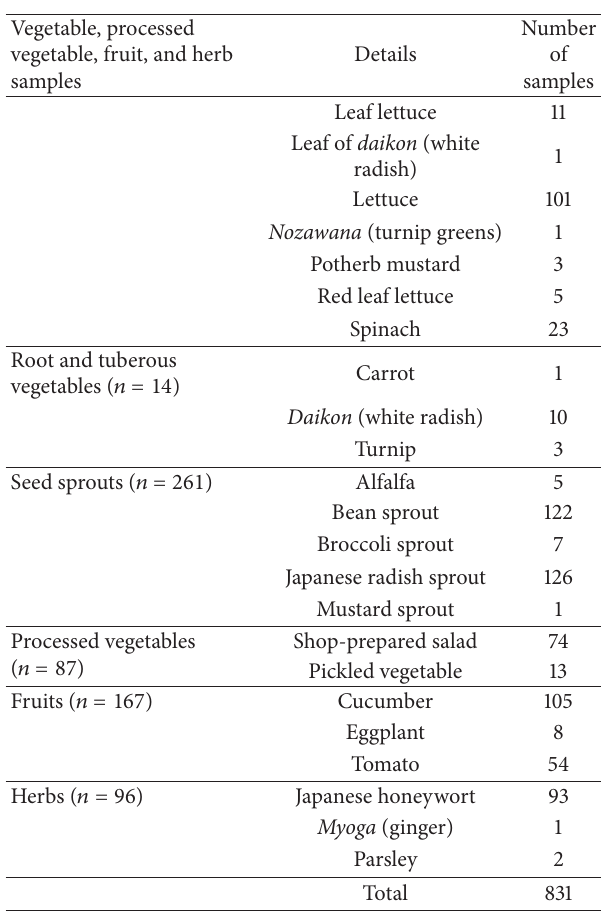
Table 3: Seafood- and vegetable-related samples (no samples harbored Salmonella